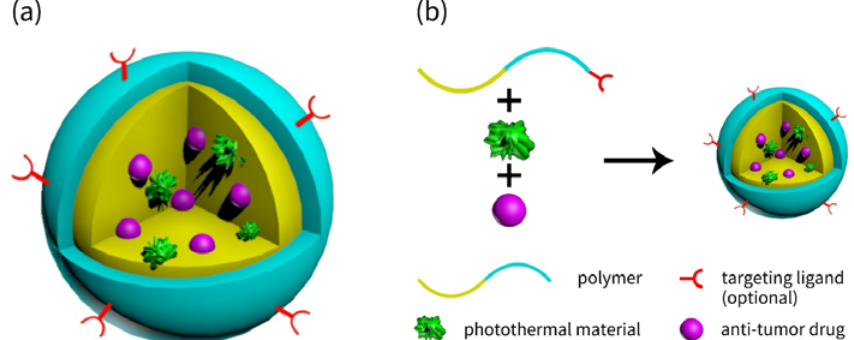
Figure 1. Schematic illustration of ( a ) the core ‐ shell structured nanocarriers and ( b ) the preparation process of such nanocarriers. Table 1 . List of Core ‐ shell Structured Nanocarriers.